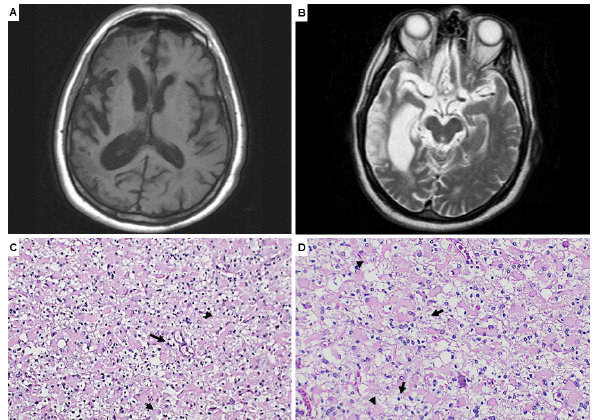
Figure 1. Brain magnetic resonance imaging – T1 axial (A) with evidence of right-side atrophy. T2 axial (B) corroborates the atrophy with temporal hyperintense signal. Histological findings in sections stained with hematoxylin and eosin show grey matter (C) with severe neuronal loss, reactive astrocytes with eosinophilic cytoplasm and tapering processes (arrowhead), and mild perivascular inflammation with few lymphocytes (arrow); white matter (D) presents microcystic cavitation, numerous gemistocytic astrocytes (arrowhead), and histiocytes (arrow). Bars: C – 200 μ m; D – 100 μ